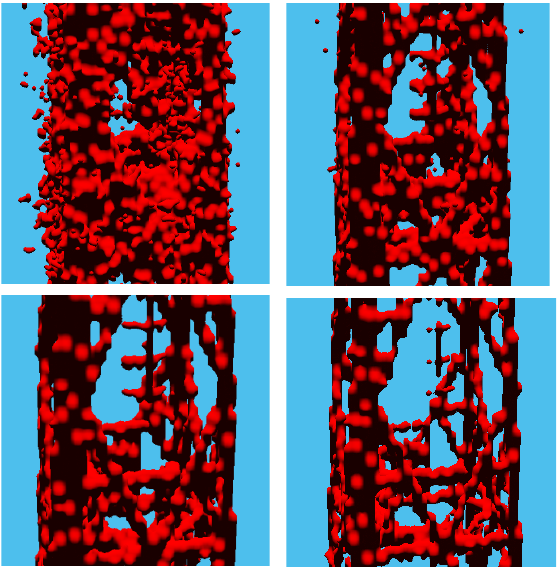
Figure 8 The voxel matrix with 10 cm resolution, filtered at 0, 20,